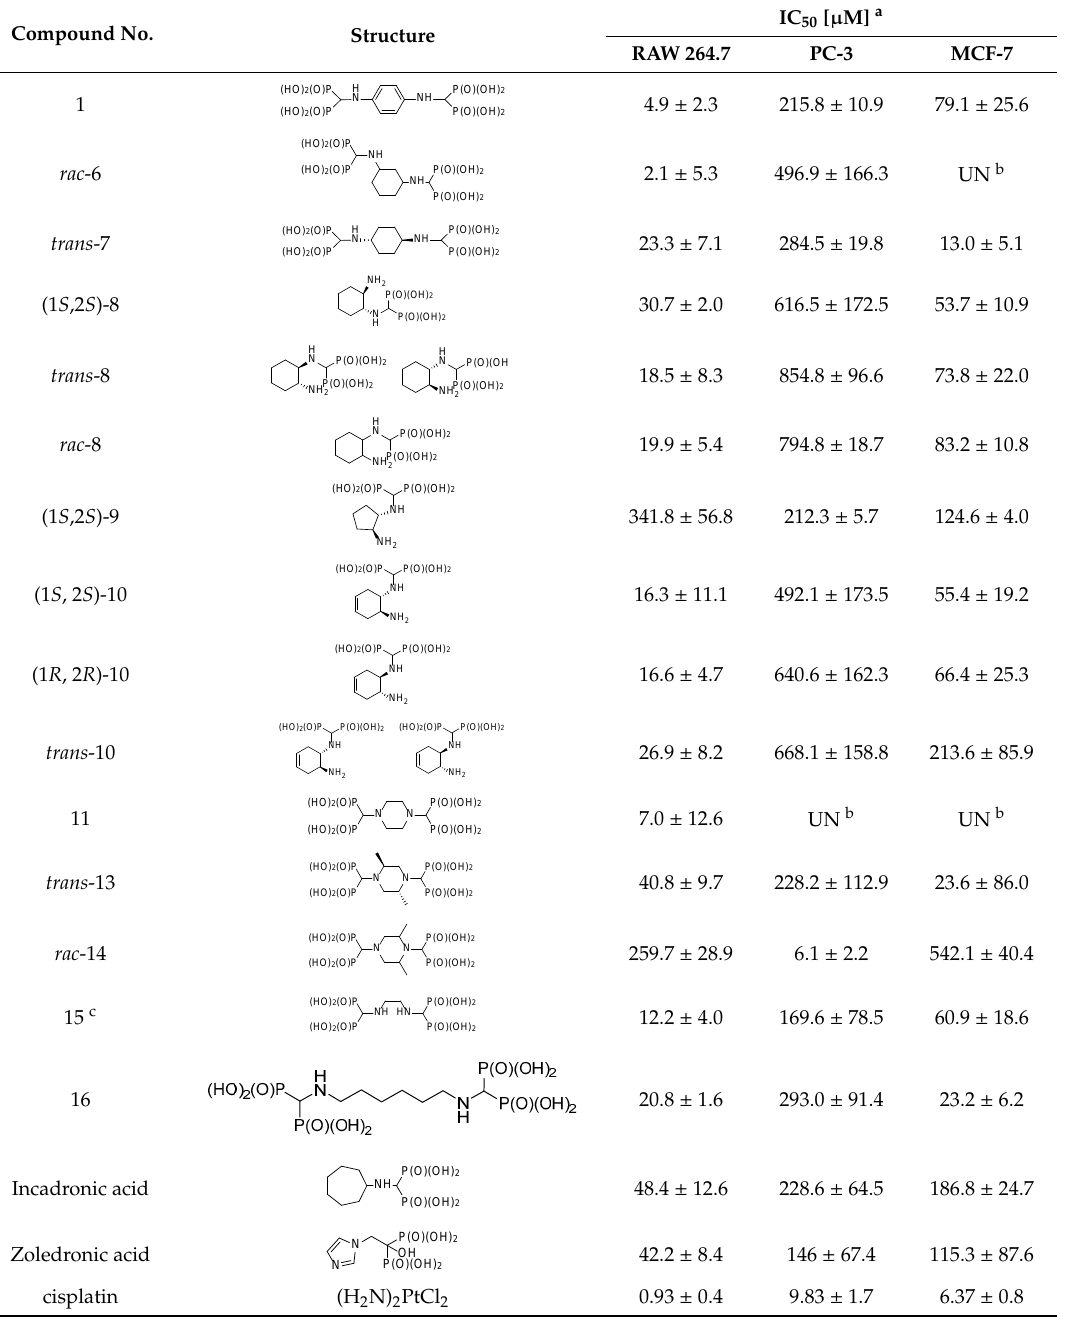
Table 1. Structures and in vitro anti-proliferative activities of bis[aminomethylenebis(phosphonic)] Table 1. Structures and in vitro anti - proliferative activities of bis[aminomethylenebis(phosphonic)] Table 1. Structures and in vitro anti - proliferative activities of bis[aminomethylenebis(phosphonic)] Table 1. Structures and in vitro anti - proliferative activities of bis[aminomethylenebis(phosphonic)] Table 1. Structures and in vitro anti - proliferative activities of bis[aminomethylenebis(phosphonic)] Table 1. Structures and in vitro anti - proliferative activities of bis[aminomethylenebis(phosphonic)] Table 1. Structures and in vitro anti - proliferative activities of bis[aminomethylenebis(phosphonic)] Table 1. Structures and in vitro anti - proliferative activities of bis[aminomethylenebis(phosphonic)] Table 1. Structures and in vitro anti - proliferative activities of bis[aminomethylenebis(phosphonic)] Table 1. Structures and in vitro anti - proliferative activities of bis[aminomethylenebis(phosphonic)] Table 1. Structures and in vitro anti - proliferative activities of bis[aminomethylenebis(phosphonic)] acids against RAW 264.7 mouse macrophages, PC-3 human prostate cancer cells and MCF-7 human Table 1. Structures and in vitro anti - proliferative activities of bis[aminomethylenebis(phosphonic)] Table 1. Structures and in vitro anti - proliferative activities of bis[aminomethylenebis(phosphonic)] Table 1. Structures and in vitro anti - proliferative activities of bis[aminomethylenebis(phosphonic)] Table 1. Structures and in vitro anti - proliferative activities of bis[aminomethylenebis(phosphonic)] acids against RAW 264.7 mouse macrophages, PC - 3 human prostate cancer cells and MCF - 7 human acids against RAW 264.7 mouse macrophages, PC - 3 human prostate cancer cells and MCF - 7 human acids against RAW 264.7 mouse macrophages, PC - 3 human prostate cancer cells and MCF - 7 human acids against RAW 264.7 mouse macrophages, PC - 3 human prostate cancer cells and MCF - 7 human acids against RAW 264.7 mouse macrophages, PC - 3 human prostate cancer cells and MCF - 7 human acids against RAW 264.7 mouse macrophages, PC - 3 human prostate cancer cells and MCF - 7 human acids against RAW 264.7 mouse macrophages, PC - 3 human prostate cancer cells and MCF - 7 human acids against RAW 264.7 mouse macrophages, PC - 3 human prostate cancer cells and MCF - 7 human acids against RAW 264.7 mouse macrophages, PC - 3 human prostate cancer cells and MCF - 7 human acids against RAW 264.7 mouse macrophages, PC - 3 human prostate cancer cells and MCF - 7 human acids against RAW 264.7 mouse macrophages, PC - 3 human prostate cancer cells and MCF - 7 human breast cancer cells. acids against RAW 264.7 mouse macrophages, PC - 3 human prostate cancer cells and MCF - 7 human acids against RAW 264.7 mouse macrophages, PC - 3 human prostate cancer cells and MCF - 7 human acids against RAW 264.7 mouse macrophages, PC - 3 human prostate cancer cells and MCF - 7 human Table 1. Structures and in vitro anti - proliferative activities of bis[aminomethylenebis(phosphonic)] Table 1. Structures and in vitro anti - proliferative activities of bis[aminomethylenebis(phosphonic)] breast cancer cells. breast cancer cells. breast cancer cells. breast cancer cells. breast cancer cells. breast cancer cells. breast cancer cells. breast cancer cells. breast cancer cells. breast cancer cells. breast cancer cells. breast cancer cells. breast cancer cells. breast cancer cells. acids against RAW 264.7 mouse macrophages, PC - 3 human prostate cancer cells and MCF - 7 human acids against RAW 264.7 mouse macrophages, PC - 3 human prostate cancer cells and MCF - 7 human breast cancer cells. breast cancer cells. Compound No. Compound No. Compound No. Compound No. Compound